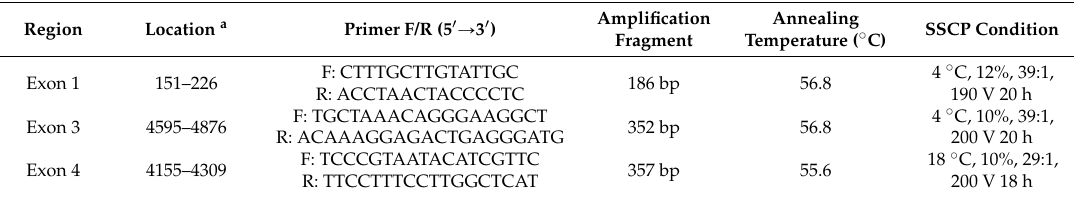
Table 1. Primer sequences and SSCP condition of SLA-DRA gene